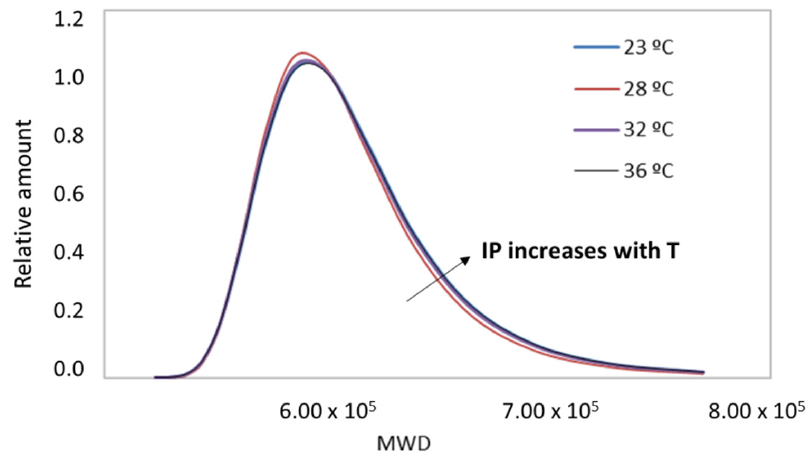
Figure 6. Distribution of molecular weights obtained with RheoWin software for the 4% wt sample at different test temperatures.